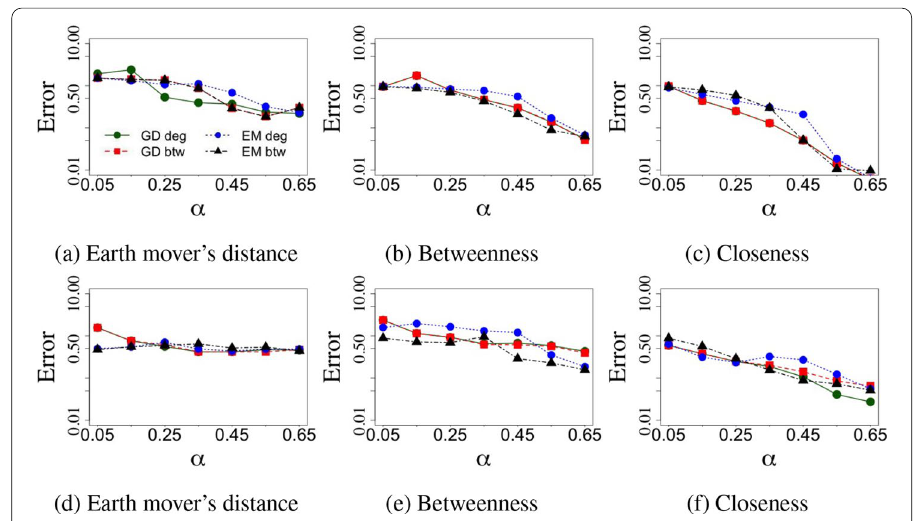
Fig. 9 Error of calculation of measures over sparsified graphs with 1000 samples: In all figures the y-axis shows the difference between the value of measures in the original graphs and the estimated value (over 1000 samples) in the sparsified graphs. The x-axis shows sparsification ratios. a – c Erdős–Rényi network with density ρ = 0.1 and MST/MC backbone ( α ′ = 0.5 α ), and d – f the brain network with noise corrected